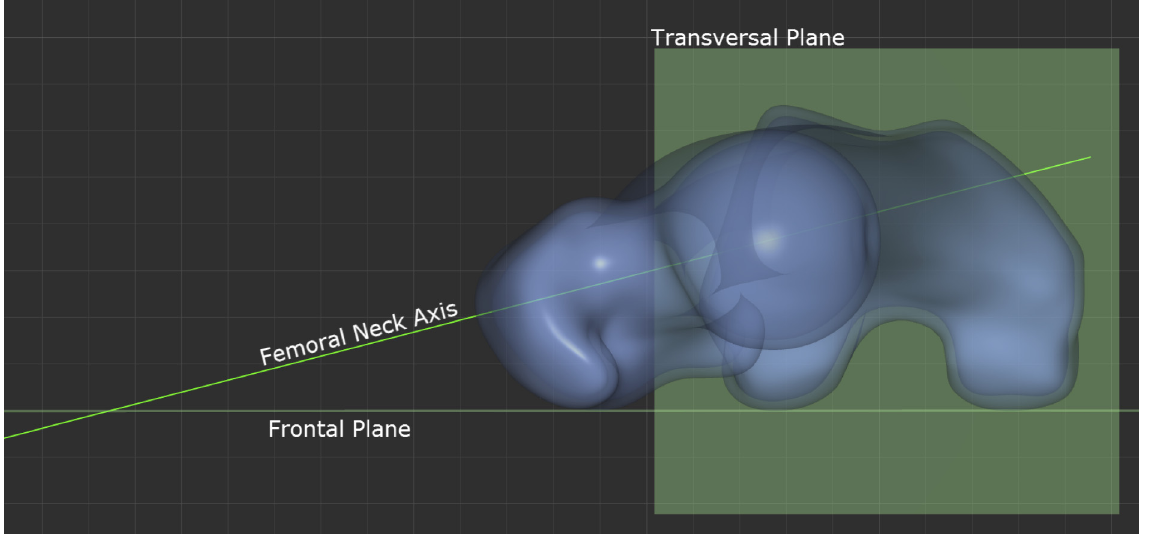
Fig 3. Fig 3 shows the measurement of femoral torsion: Angle between frontal plane and femoral neck axis projected onto transversal